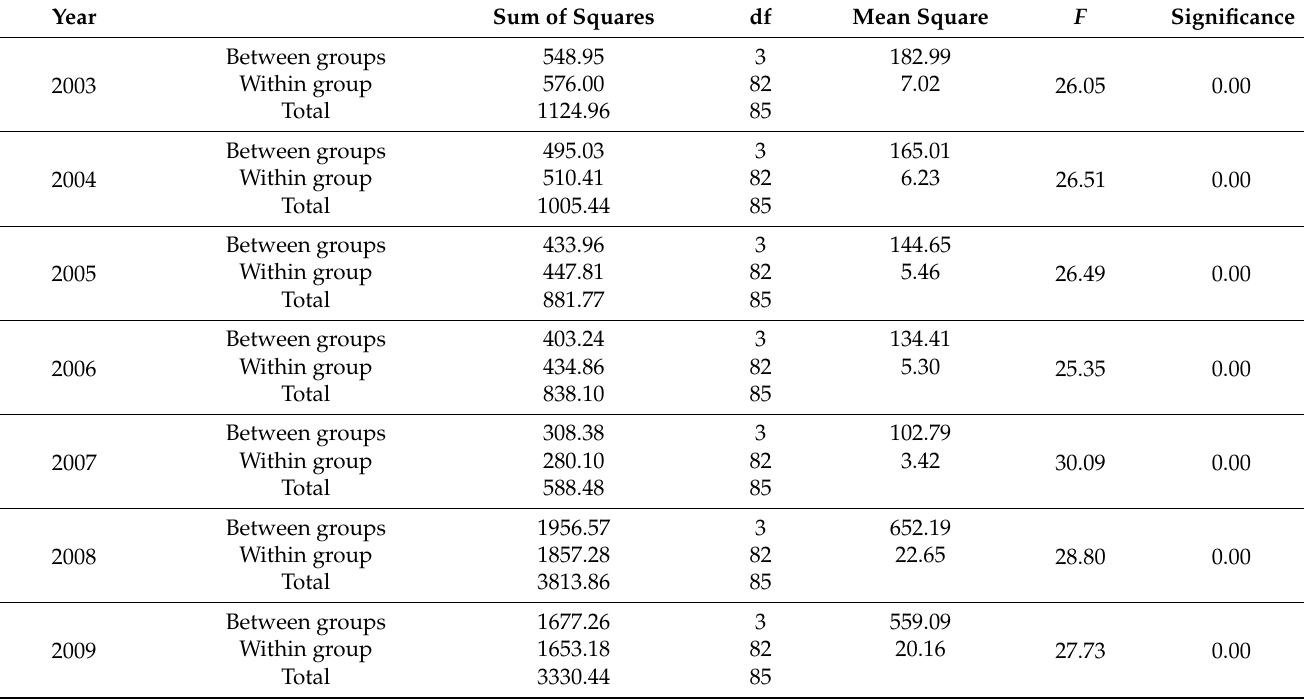
Table A2. The results of ANOVA between areas and non-areas in Guizhou province from 2003 to